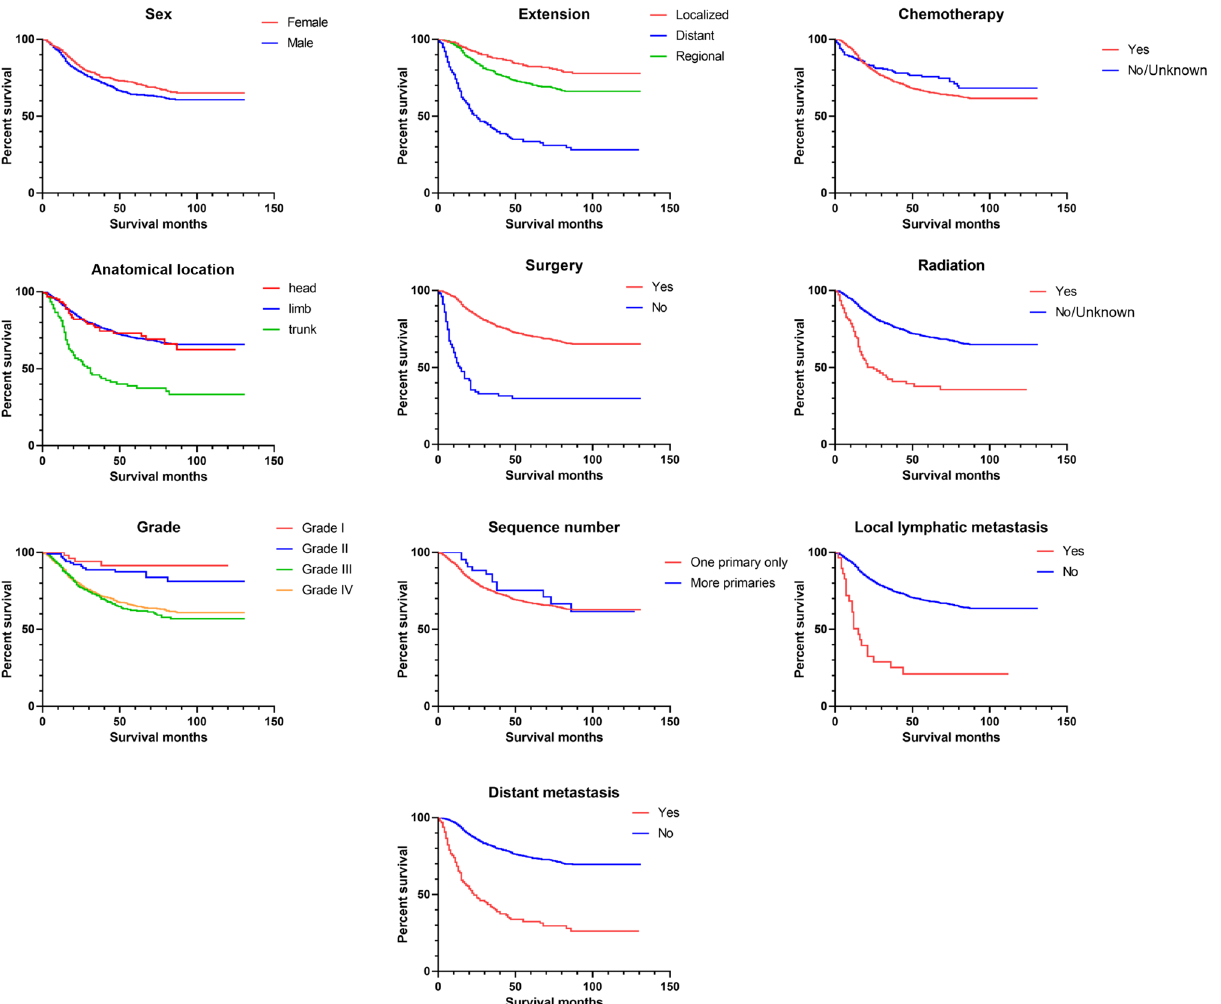
Figure 3. Kaplan–Meier survival curves to evaluate the influence of the ten classified characteristics (sex, anatomical location, histological grade, radiation, chemotherapy, tumor extension, primary tumor number, local lymphatic metastasis, distant metastasis, and surgery) for osteosarcoma patient survival. Anatomical location, site of the primary tumor. The figure was created by using GraphPad Prism 7 (https ://www.graph pad.com/).